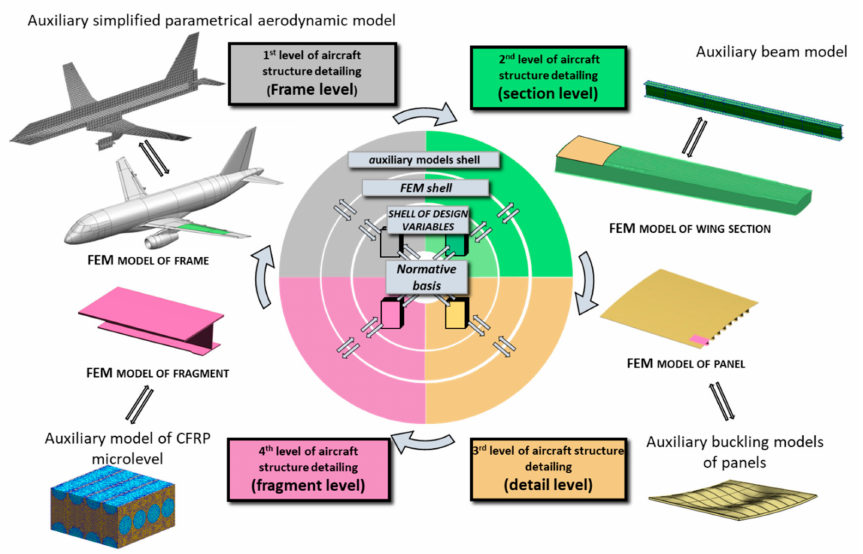
Figure 1. Scheme of calculation procedure in frame of the base four-level algorithm